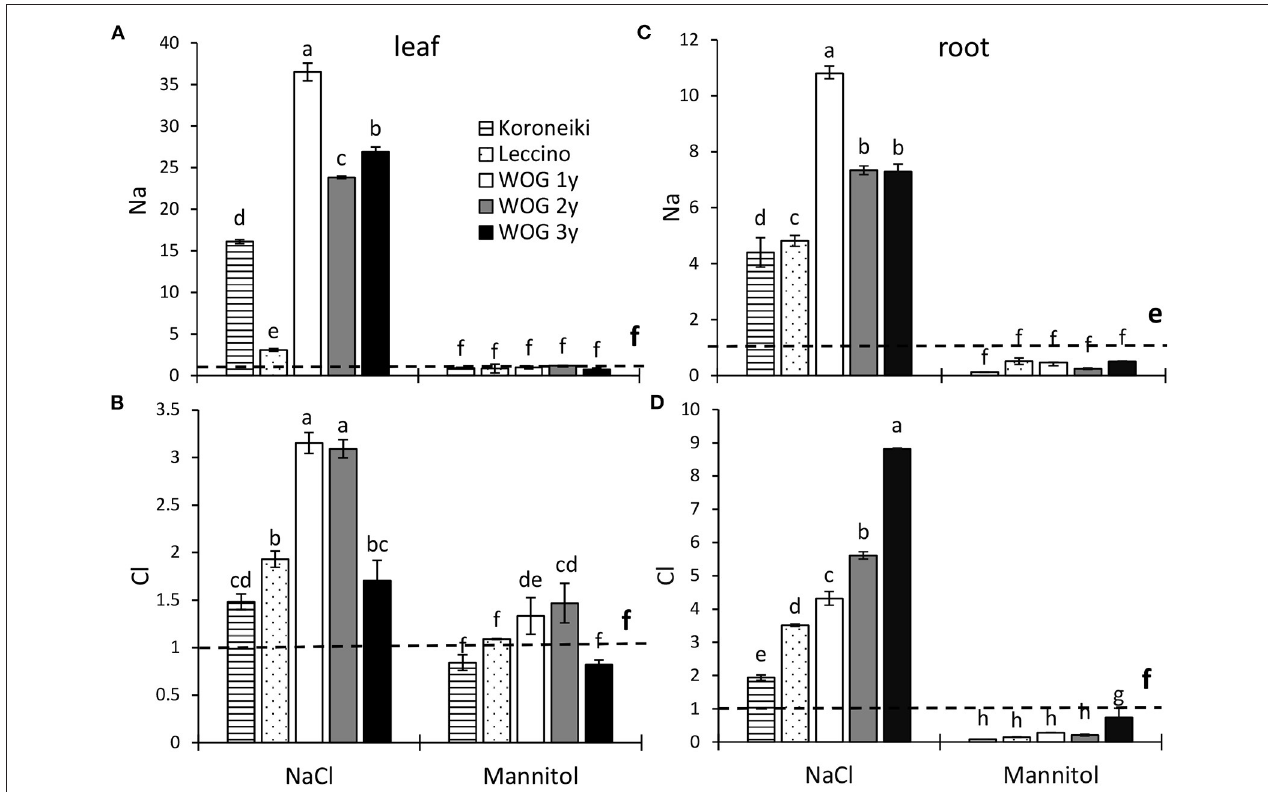
FIGURE 1 | The relative contents of leaf Na + (A) , leaf Cl − (B) , root Na + (C) , and root Cl − (D) ions of olive after exposure to NaCl or mannitol. Controls are normalized to the value 1. Columns marked with different letters are statistically significantly different ( p ≤ 0.05). The bars represent mean ± SD, n = 3. Raw data are presented in Supplementary Tables 2, 2a . SD, standard